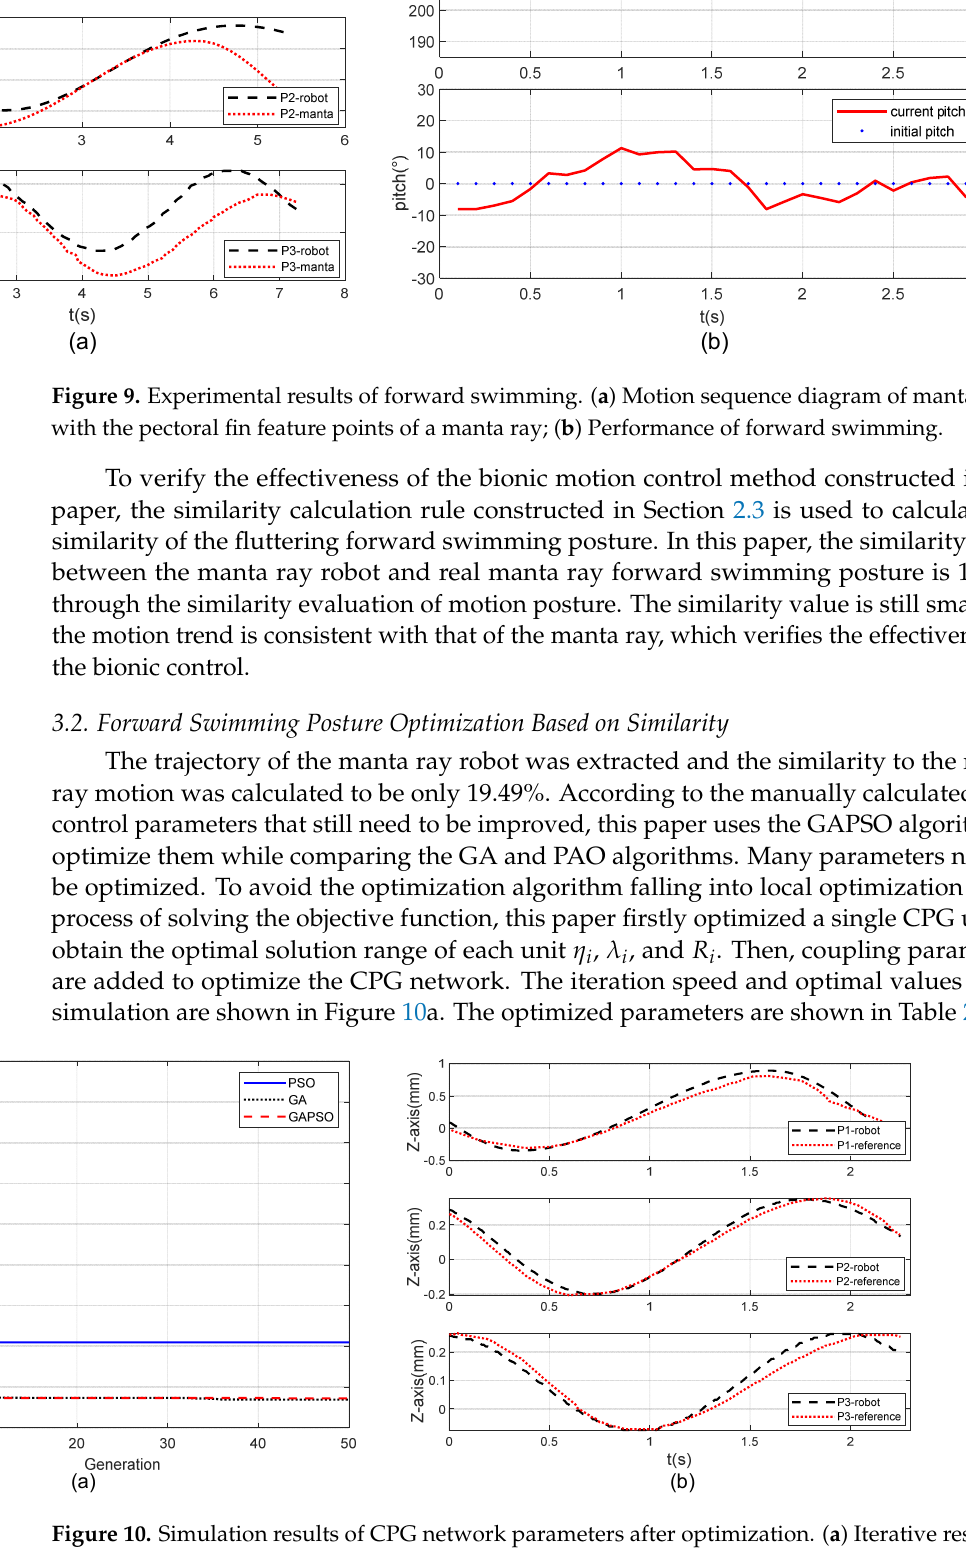
Figure 10. Simulation results of CPG network parameters after optimization. ( a ) Iterative results of GA, PSO, and GAPSO optimal individual fitness values graph; ( b ) CPG optimized result graph.